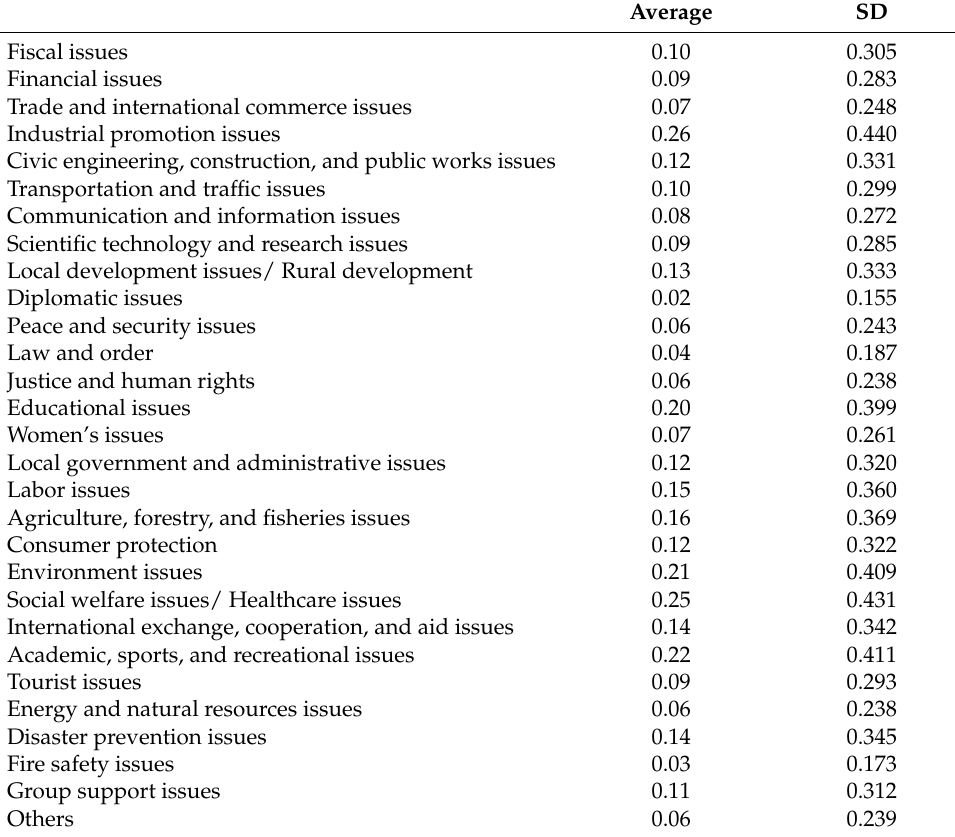
Table 2. Average and standard deviation (SD) of each organizational